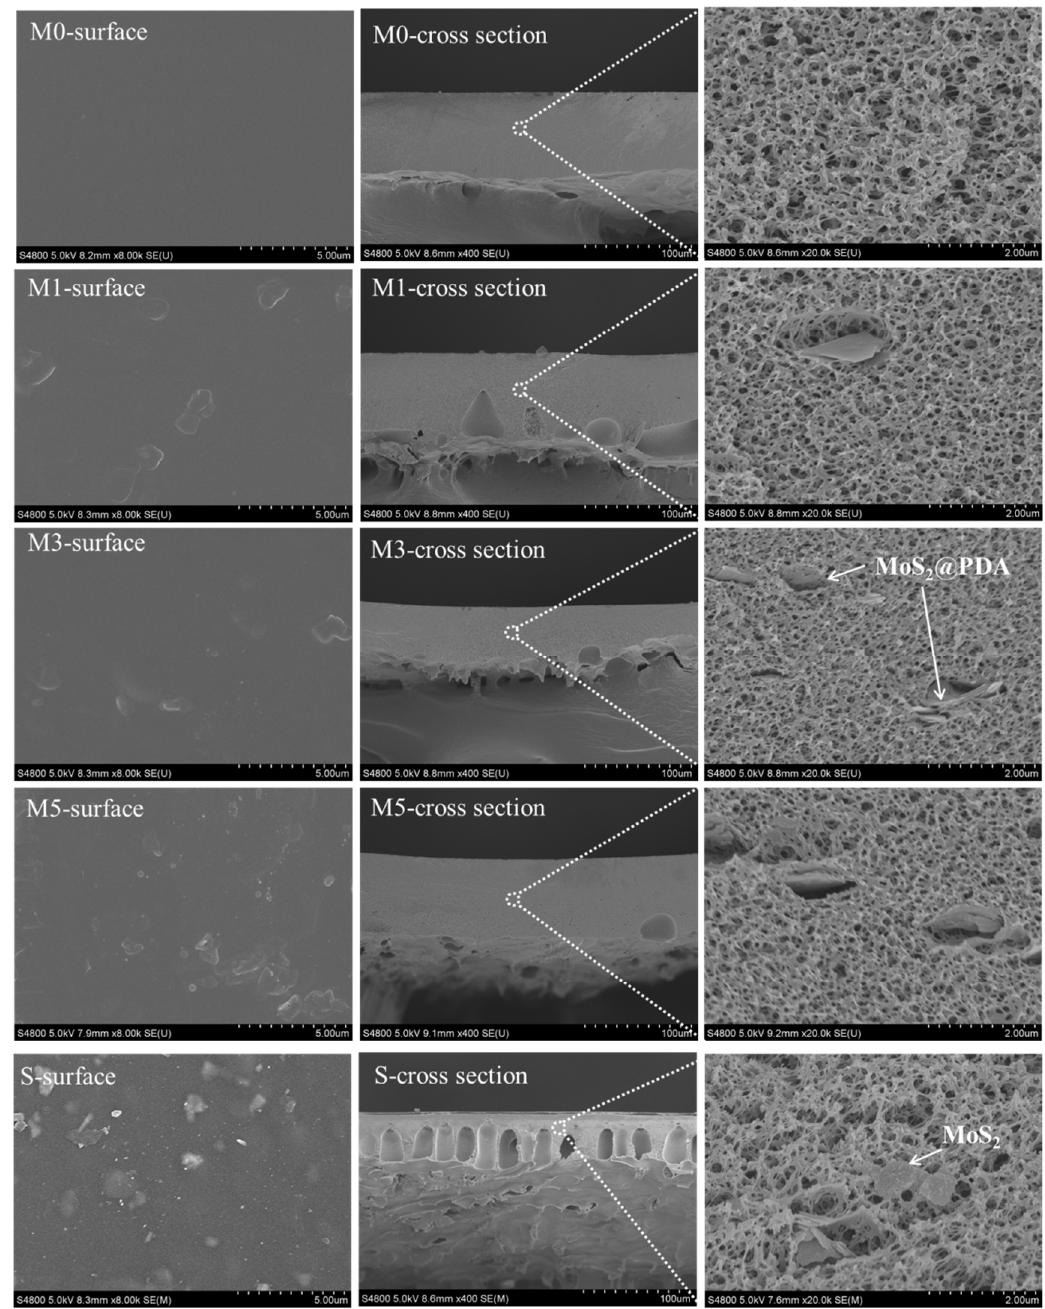
Figure 6. SEM images of PES and MoS 2 @PDA/PES membranes (M0, M1, M3, and M5) and MoS 2 /PES (3.0 wt % of MoS 2 ) mixed matrix membrane (S).